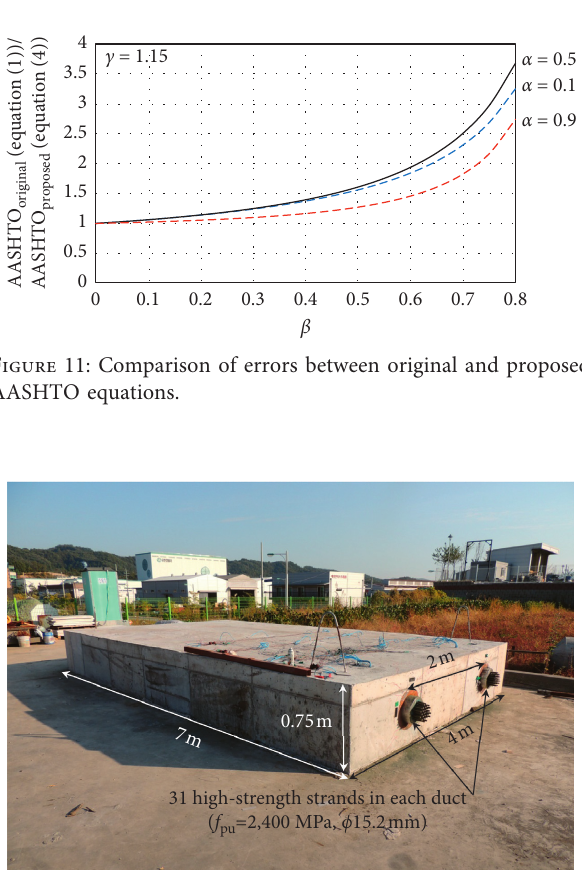
Figure 13: Location of concrete embedment strain gauges.